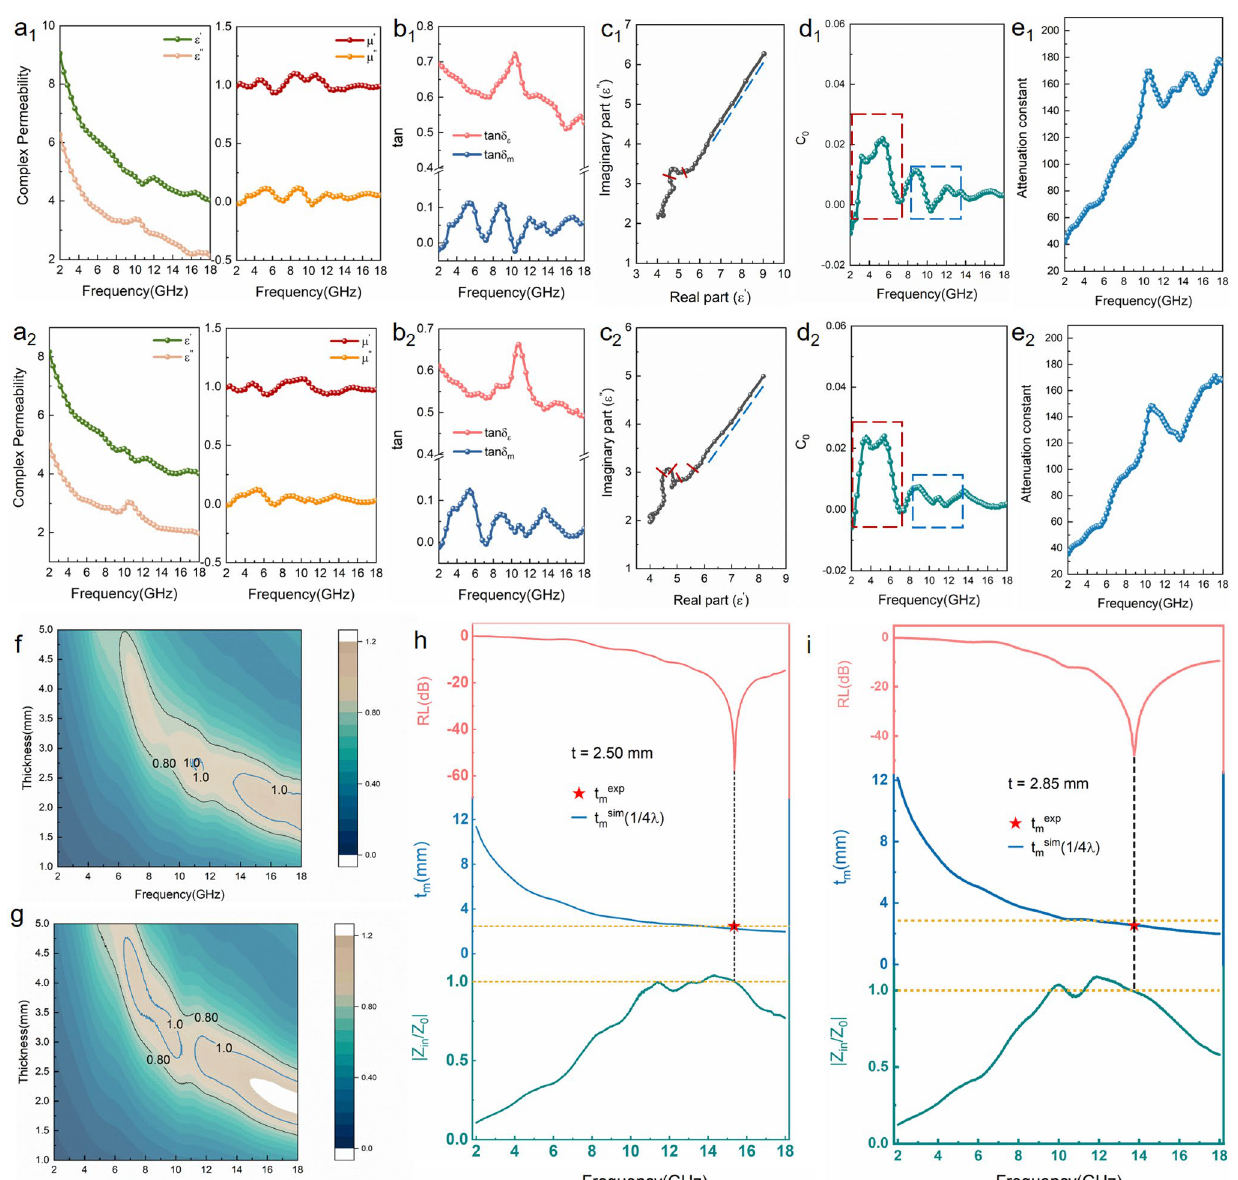
Fig. 7 a Complex permittivity and permeability, b dielectric and magnetic loss tangents (tan δ ε and tan δ μ , respectively), c Cole–Cole curves ( ε ′ – ε ″ plots), d C 0 – f curves, e attenuation constant (α), f , g impedance matching ( Z in / Z 0 ) and h , i RL/ t m / Z − f curve for the prepared Fe 3 O 4 @C/ rGO and Ni-doped Fe 3 O 4 @C/rGO